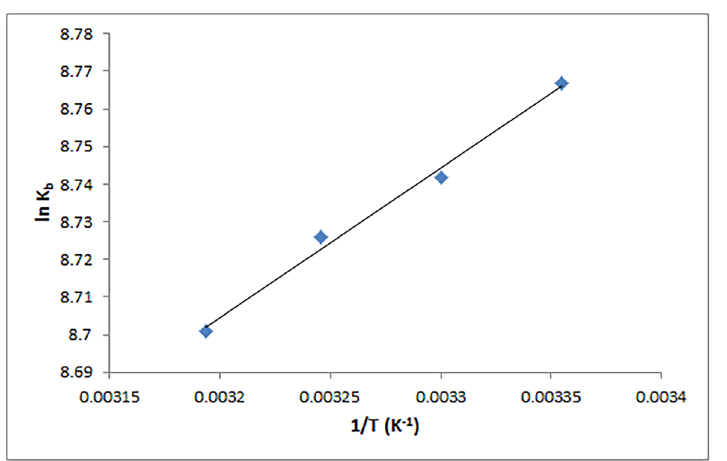
Figure 7. Van’t Hoff plot for the CT-DNA-PLB